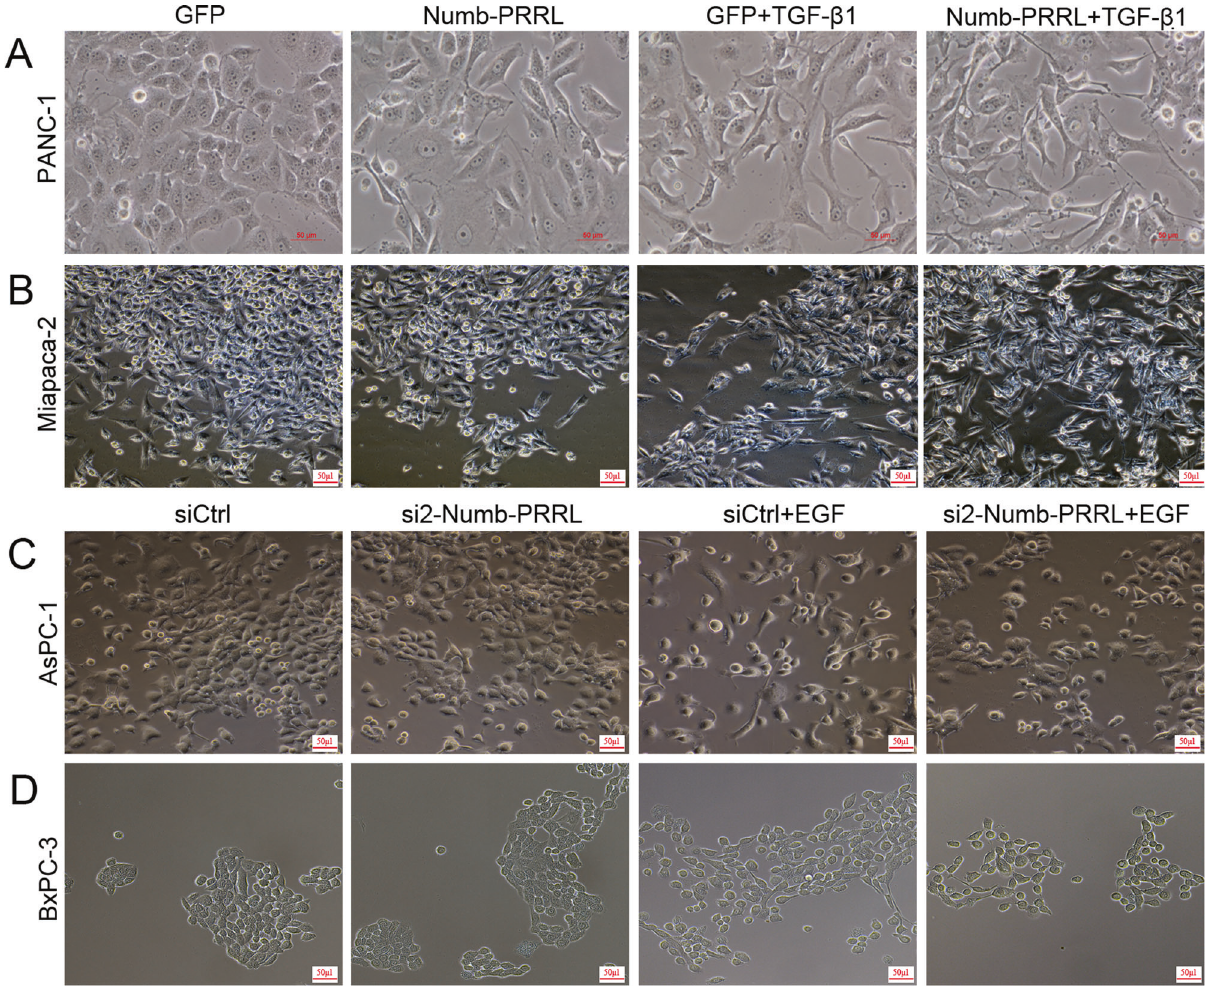
Fig. 3 Numb-PRRL promoted TGF- β 1- and EGF-induced EMT-like cell morphology in vitro. A , B Numb-PRRL overexpression promoted TGF- β 1-induced EMT-like cell morphology in PANC-1 ( A ) and Miapaca-2 ( B ) cells. C , D Numb-PRRL silencing inhibited EGF-induced EMT-like cell morphology in AsPC-1 ( C ) and BxPC-3 ( D ) cells.